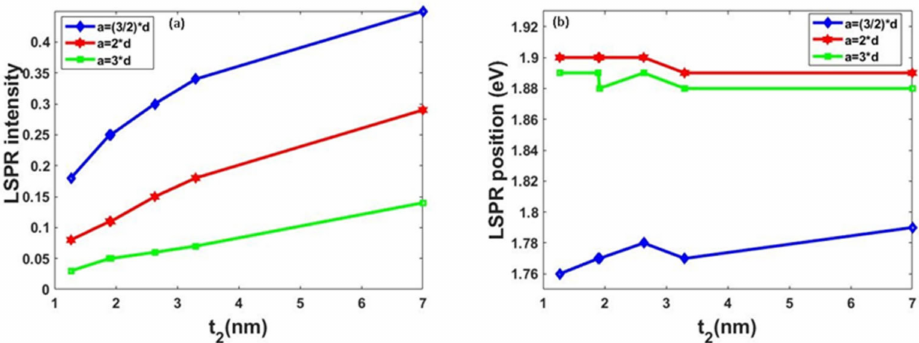
Figure 6. Size dependent LSPRs ( a ) intensity; ( b ) LSPRs position for d = 2.54 nm, 3.8 nm, 3,84 nm, 5.27 nm, 6.6 nm, 14